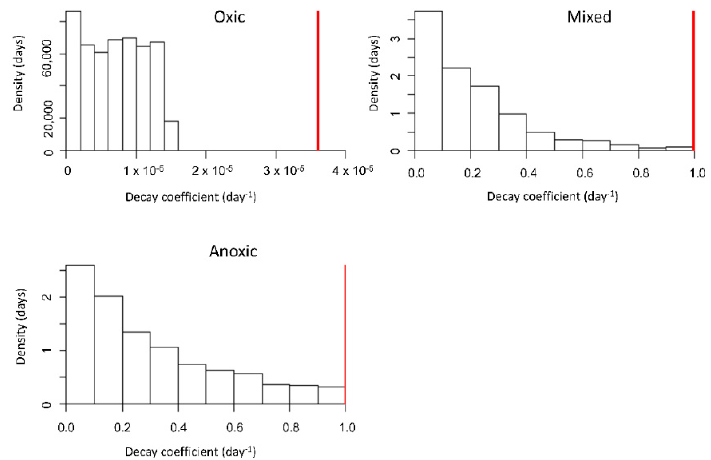
Figure 6. Distribution of groundwater decay coefficients for oxic, mixed and anoxic conditions. The posterior distribution is the histogram bars, while the prior value is the red line.